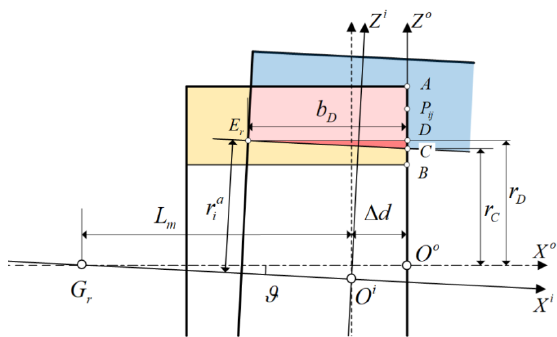
Figure 6. Analysis of the contact area of AMGC in the positive direction of z -axis.